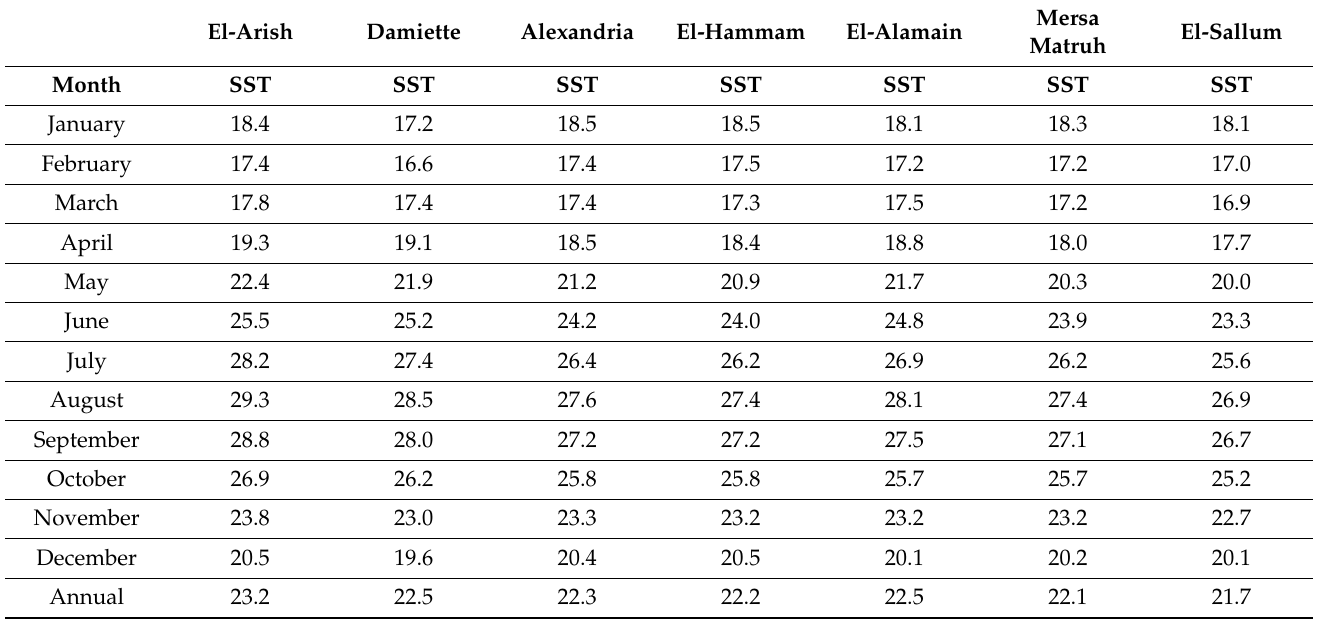
Table 7. Results of Mann–Kendall test (MK) and seasonally adjusted Mann–Kendall test (MK*) in El-Arish, Alexandria, Mersa Matruh, and El-Sallum and in additional stations such as Damiette, El-Hammam, and El-Alamain.